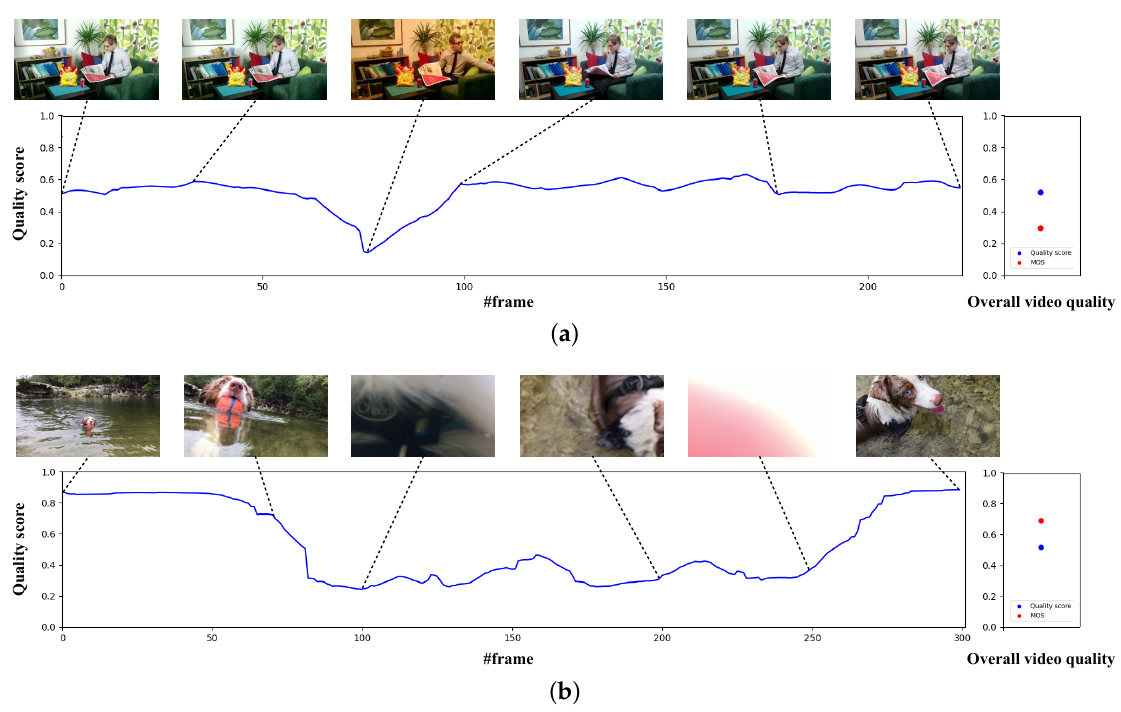
Figure 6. (Best viewed in colors and magnified.) Visualization of two samples of video quality overstated or undervalued by the proposed method: ( a ) sample video from CVD2014, and ( b ) video sequence of the LIVE-VQC database. On the left we show the frame-level predictions obtained before the Temporal Average Pooling of the Temporal Hysteresis Pooling layer, while on the right we report the overall video quality MOS and the corresponding predicted